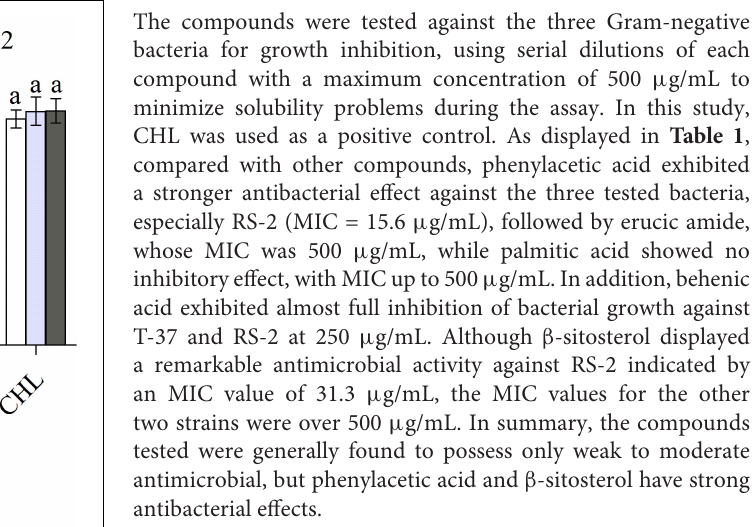
(C-18), 19.3 (C-19), 36.1 (C-20), 18.9 (C-21), 33.8 (C-22), 29.0